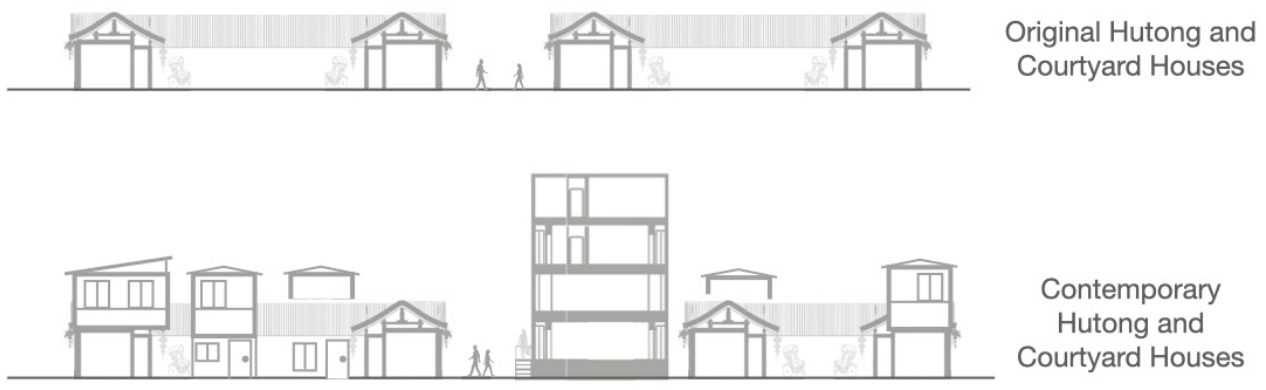
Figure 3. The section of Qian Yuan’en Si neighborhood.